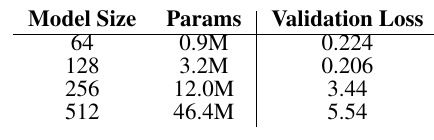
Table 2. Ablation on core model